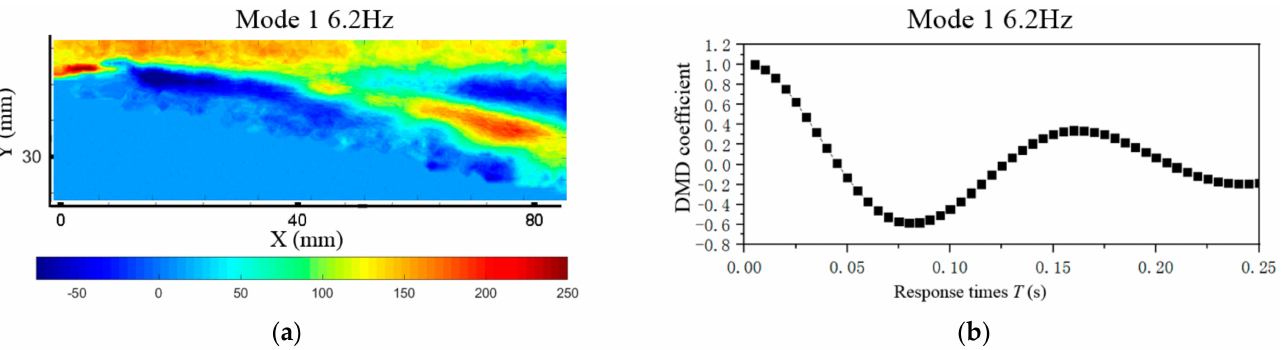
Figure 14. First − order mode PSD = 6.2 Hz. ( a ) Decomposition results of the PIV velocity nephogram modal DMD in the Region A; ( b ) the DMD modal coefficient curve in the Region A.